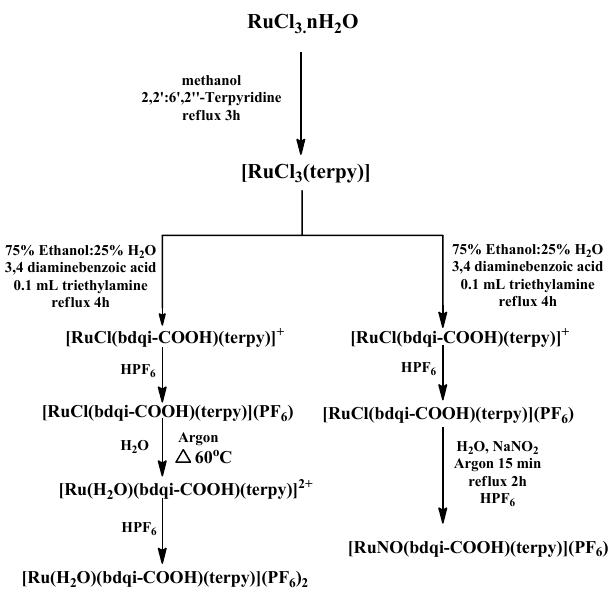
Figure 2. Synthesis pathway for obtaining complexes [Ru(bdqi ‐ COOH)(terpy)(NO)](PF 6 ) 3 , (Ru ‐ NO) and [Ru(H 2 O)(bdqi ‐ COOH)(terpy)](PF 6 ) 2 , (Ru ‐ aqueous).